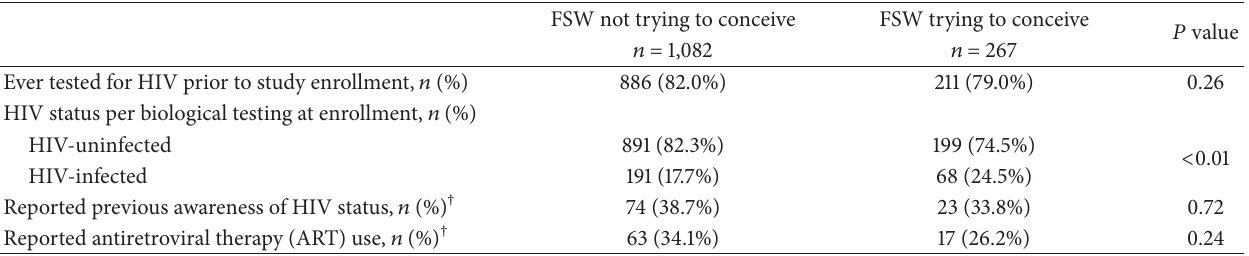
Table 2: HIV status and engagement in care by fertility intentions of female sex workers sampled in two cities in Burkina Faso and two cities in Togo ( 𝑛 =